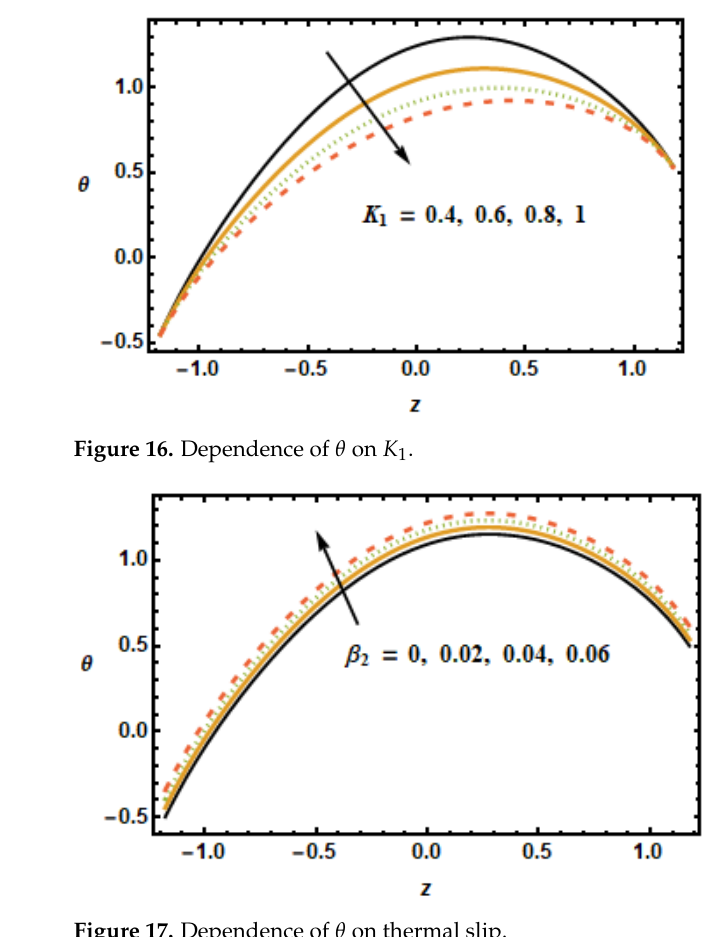
Figure 17. Dependence of θ on thermal slip.